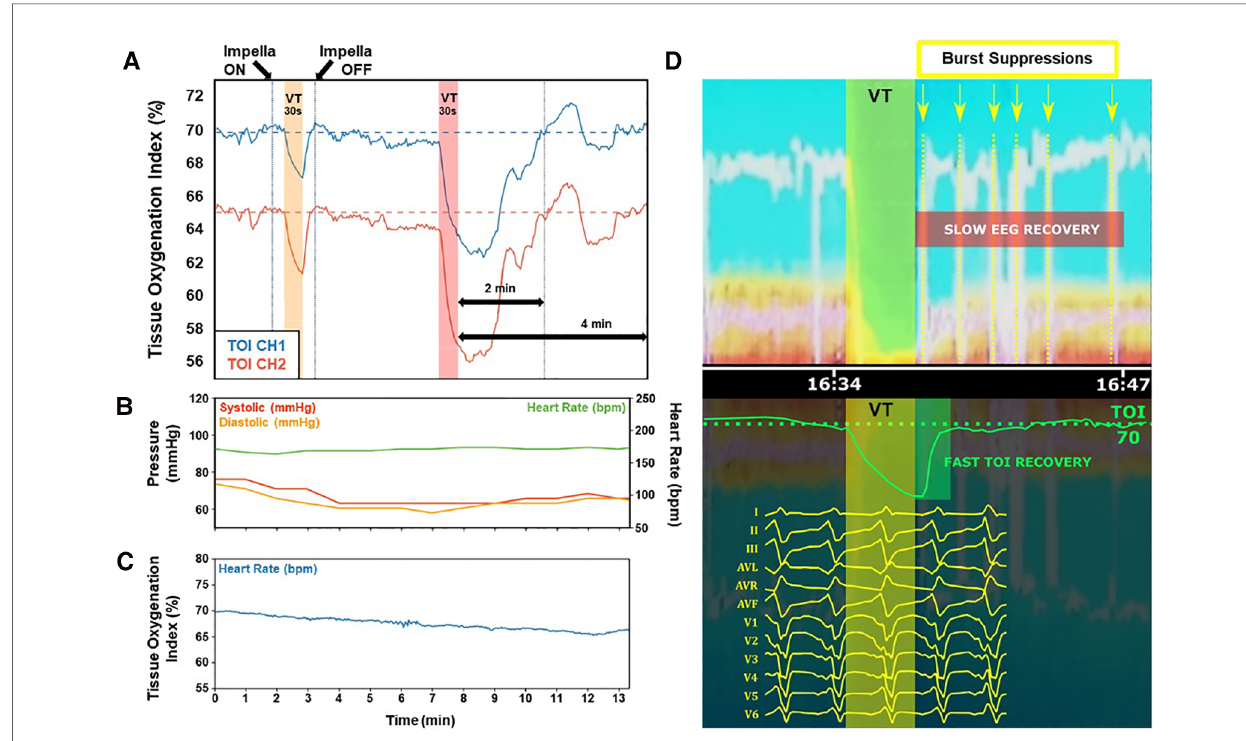
FIGURE 1 Clinical parameters of case studies. ( A ) Tissue oxygenation index (TOI) is signi fi cantly preserved and recovers quickly when Impella device is on during VT (yellow region). Without Impella support during VT (red region), TOI de fi cits are signi fi cantly more severe with subsequent instability and slower recovery. ( B ) Typical nonpulsatile fl ow is demonstrated during VT mapping, without clear indications of what MAP values are acceptable for end organ perfusion. ( C ) Preserved and stable TOI indicating adequate brain oxygenation demonstrates very little variation during the procedure. ( D ) A sudden deterioration of perfusion was observed despite stable VT cycle length and pressure curves after more than 30 min of mapping (bottom). EEG monitoring revealed a near complete loss of electrical brain activity, indicating a loss of adequate brain oxygenation (top). TOI recovery was near-immediate (bottom), but EEG monitoring demonstrated a burst suppression pattern (indicating suboptimal brain function) for several minutes after VT termination (top). VT, ventricular tachycardia; TOI, tissue oxygenation